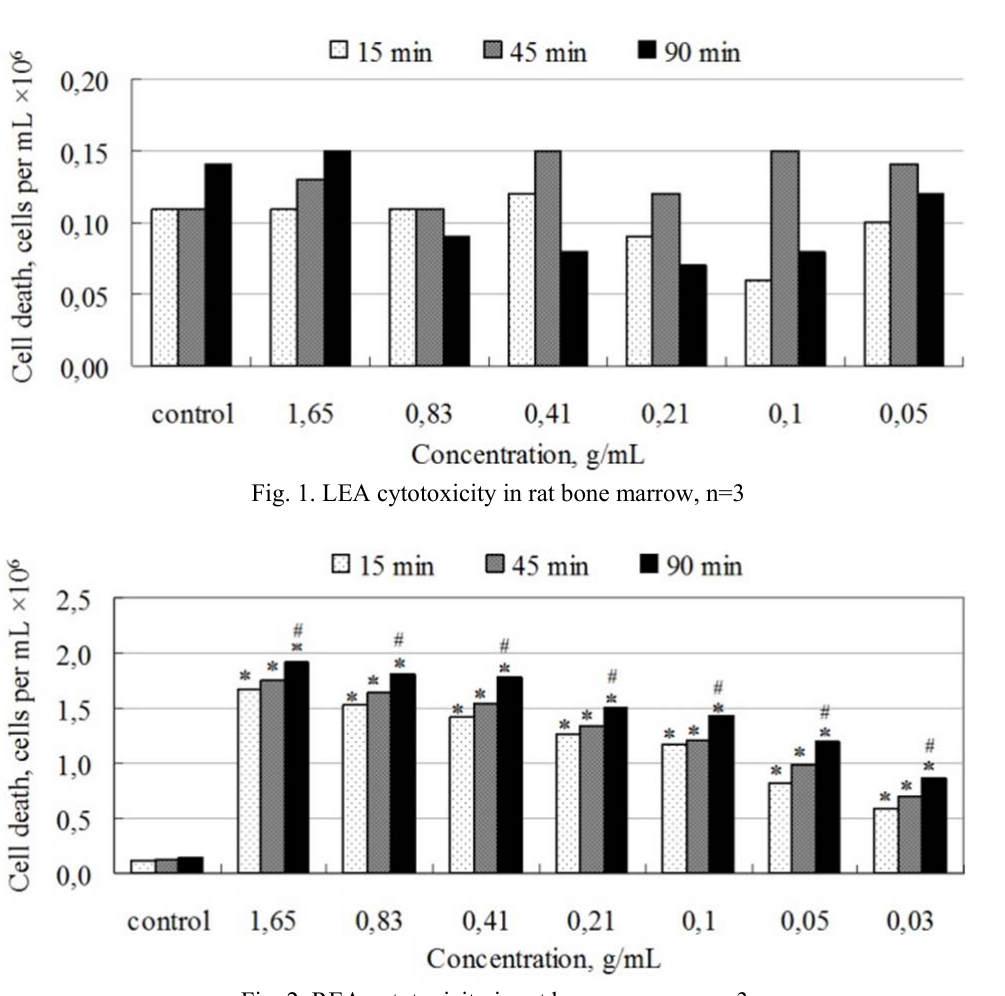
Fig. 2. REA cytotoxicity in rat bone marrow, n =